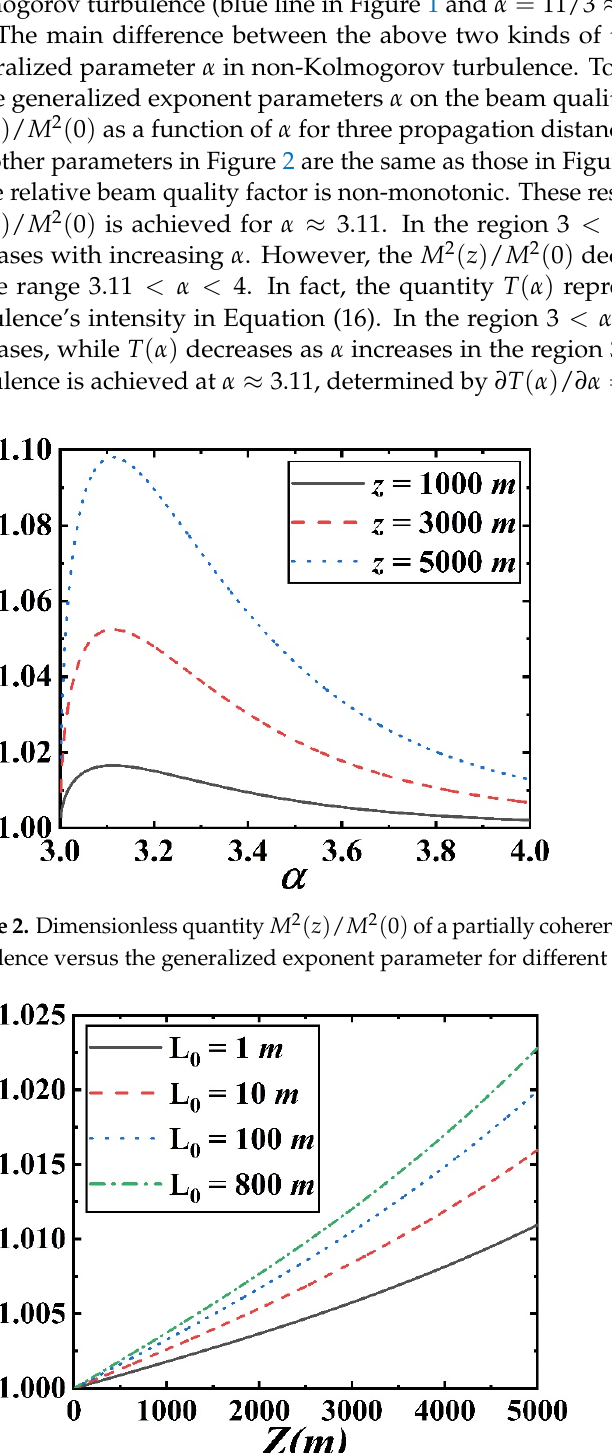
non-Kolmogorov turbulence (black, red and green lines in Figure 1) is distinct from that of Kolmogorov turbulence (blue line in Figure 1 and α = 11/3 ≈ 3.67).